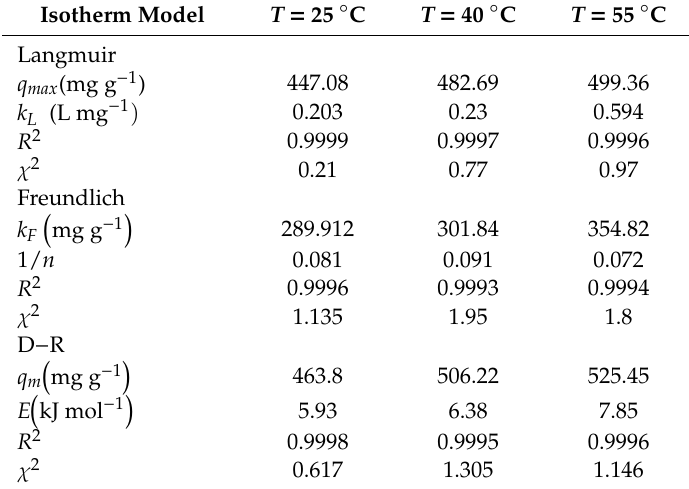
Table 4. Parameters of isotherms models for the adsorption of CV on MNP / CTAB-EC composite.